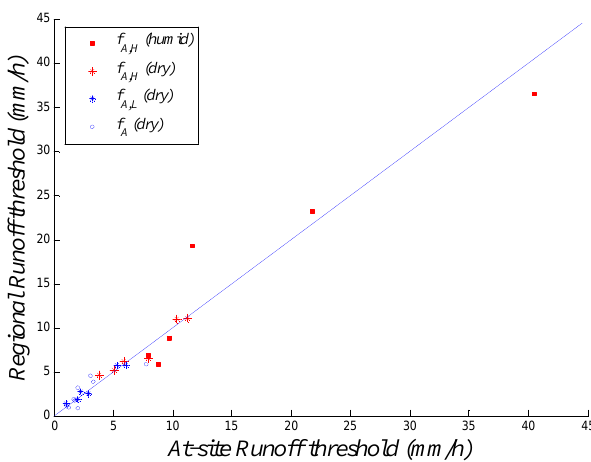
Fig. 3. Scaling relationship of the runoff thresholds for all river basins.